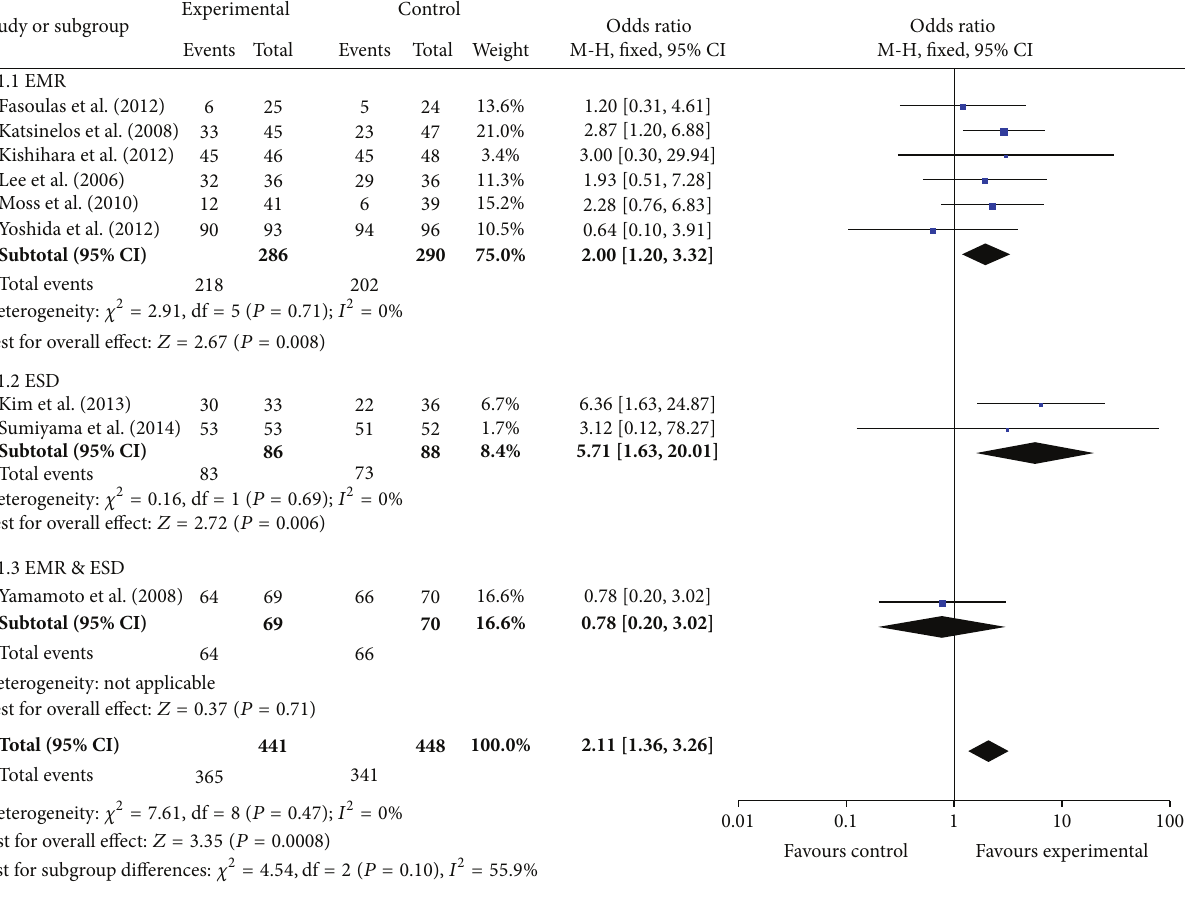
Figure 3: Meta-analysis results of en bloc resection rate between the two